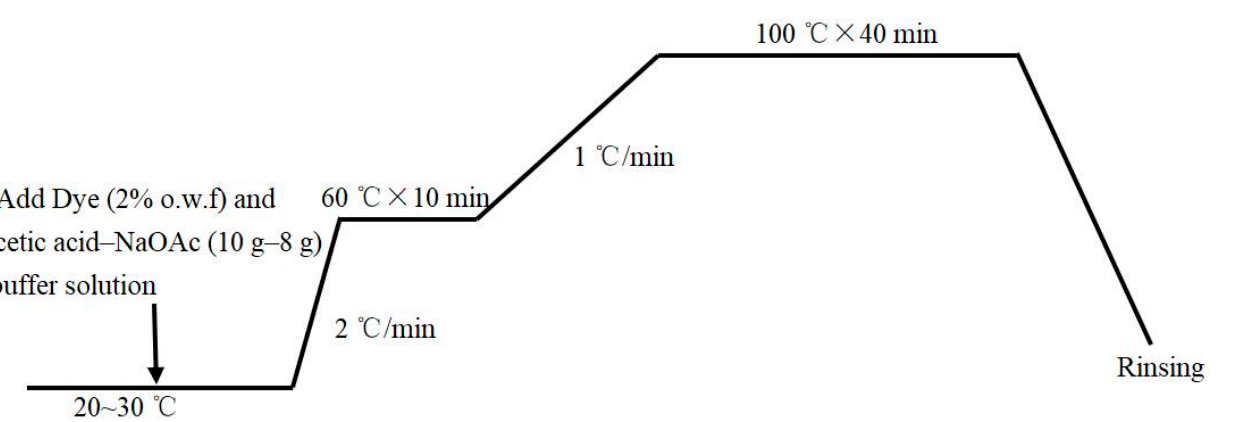
Figure 1. The dyeing process.